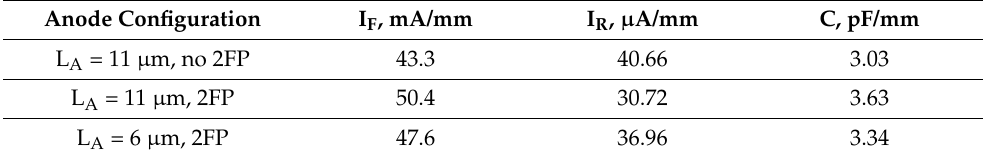
Table 1. Comparison of electrical parameters of performance rectifiers with different anode designs. Anode Configuration